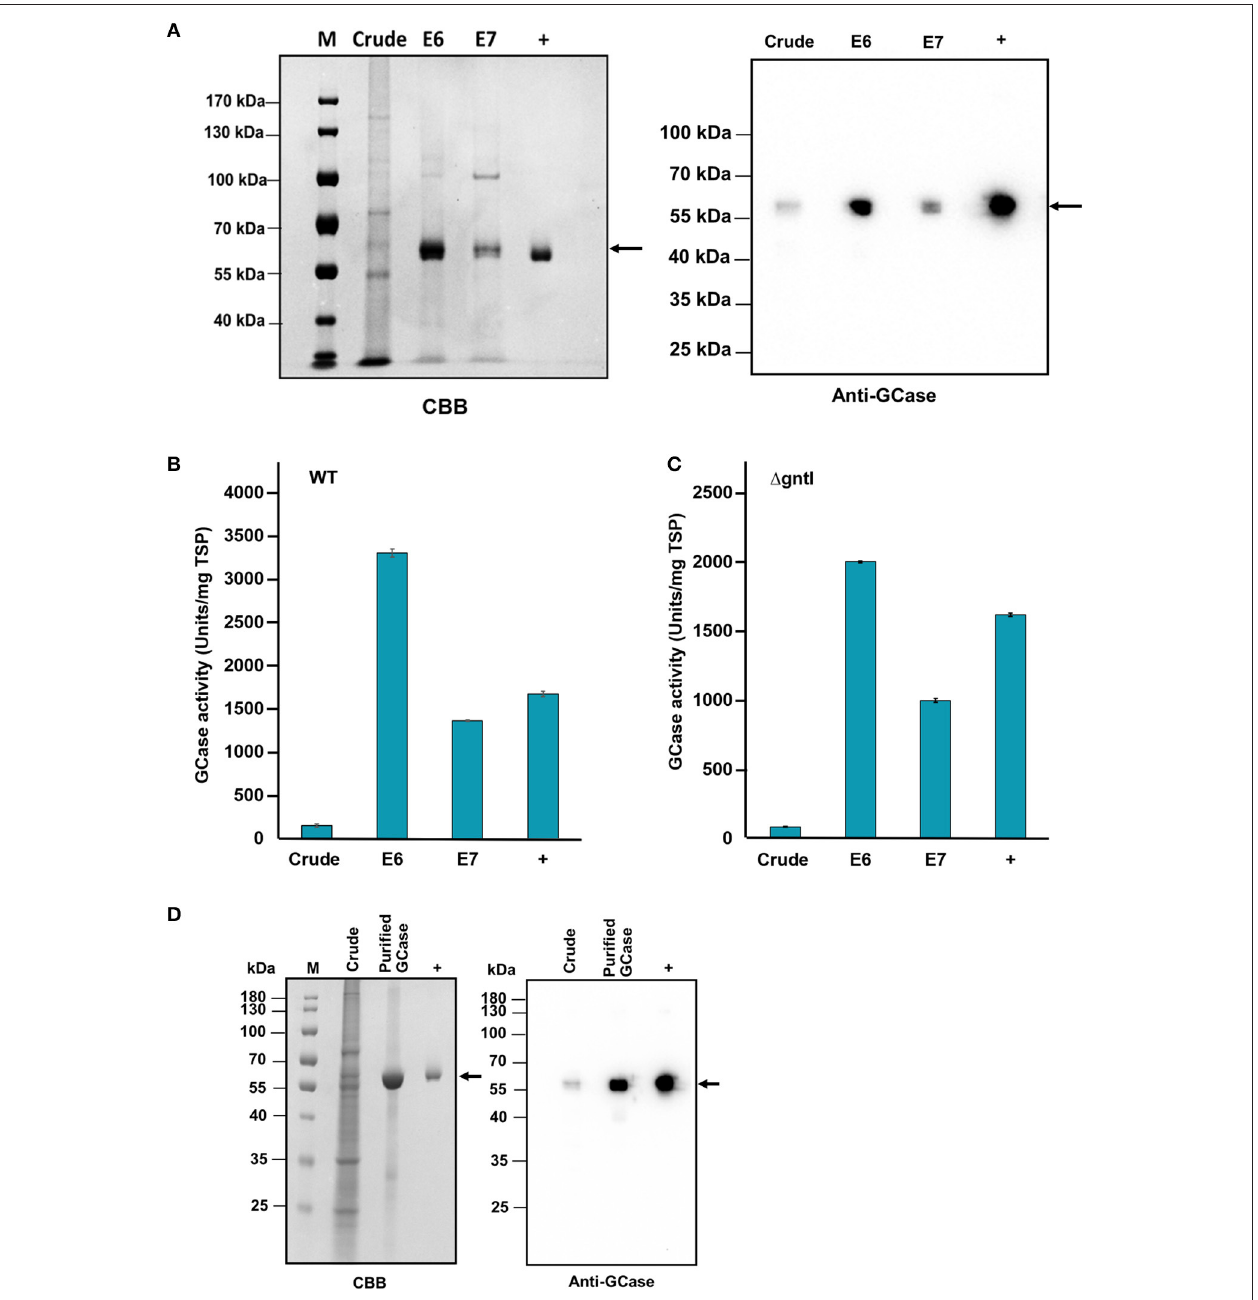
FIGURE 3 | GCase purification from infiltrated wild-type (WT) and 1 gntI N. benthamiana leaves. (A) Total proteins from infiltrated WT leaves (E6 and E7); 2.5 µ g and 100 ng were loaded and analyzed by CBB staining and Western blotting, respectively. (B) GCase activity of crude protein and purified GCase from infiltrated WT leaves: elution fractions 6 and 7. Error bars represent the standard deviation (SD) ( N = 3). (C) GCase activity levels of crude protein and purified GCase from infiltrated 1 gntI leaves: elution fractions 6 and 7 (E6 and E7). Error bars represent the standard deviation (SD) ( N = 3). (D) CBB staining and Western blot analysis of crude protein and purified GCase from infiltrated 1 gntI leaves elution fraction 6. M, PageRuler TM protein ladder; Crude, crude protein; Purified GCase, purified GCase from Phenyl 650M elution fractions 6 (E6); + , Cerezyme ® .